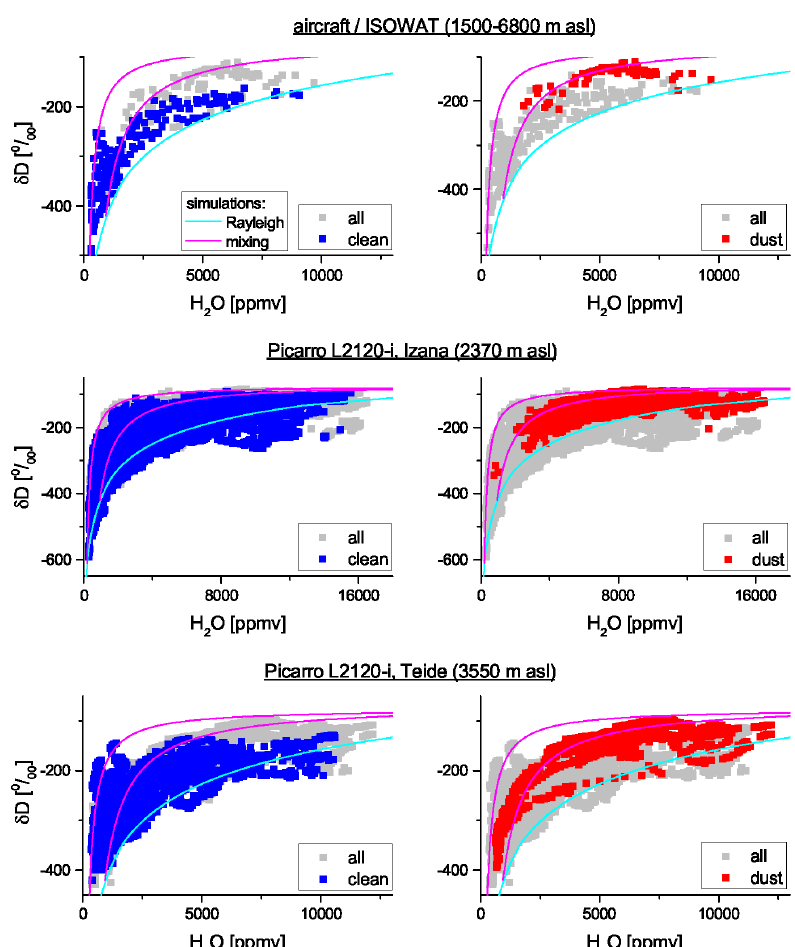
Figure 14. δ D–H 2 O plot observed from March 2012 to October 2014 at and close to Tenerife by different in situ instruments at different altitudes. Grey dots: all data; blue dots: for air mass not affected by the African continent; red dots: for air mass affected by strong verti- cal mixing over the African continent. In addition all panels show the same simulated curves as depicted in Fig. 12. Cyan line: Rayleigh curve for initialization with T = 25 ◦ C and RH = 80%. Magenta lines: two mixing lines. First for mixing between H 2 O[1] = 25000ppmv; δ D[1] =− 80‰ and H 2 O[2] = 900ppmv; δ D[2] =− 430‰. Second for mixing between H 2 O[1] = 25000ppmv; δ D[1] =− 80‰ and H 2 O[2] = 200ppmv; δ D[2] =−